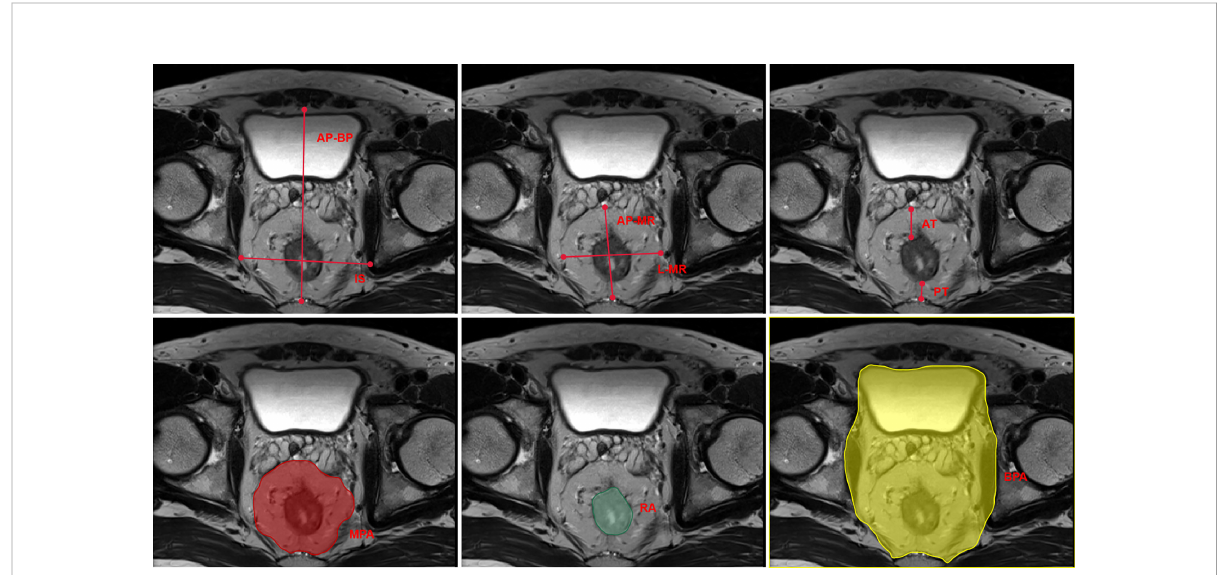
FIGURE 1 Schematic plot of the pelvic MRI measurements. MRI, magnetic resonance imaging; IS, interspinous distance; AP-BP, anterior – posterior bony pelvis span; L-MR, lateral mesorectal span; AP-MR, anterior – posterior mesorectal span; AT, anterior mesorectal thickness; PT, posterior mesorectal thickness; MPA, mesorectalpackage area; RA, rectal area; BPA, bony pelvis